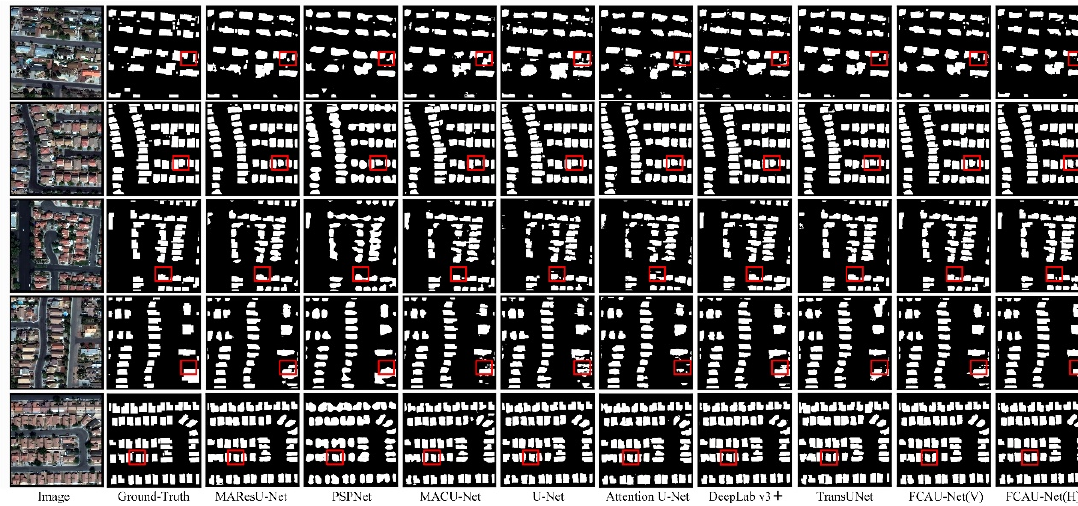
Figure 11. The experimental results obtained on the DeepGlobe dataset. Table 3. Comparison with other